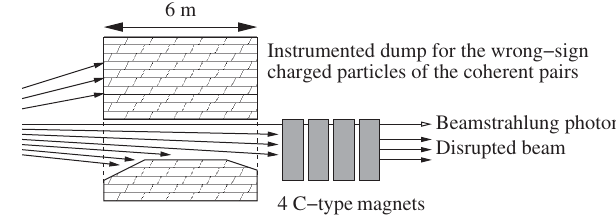
FIG. 12. Schematic layout of the transport line between the separation region and the C-type magnets, which passes through the instrumented dump of the wrong-sign charged particles of the coherent